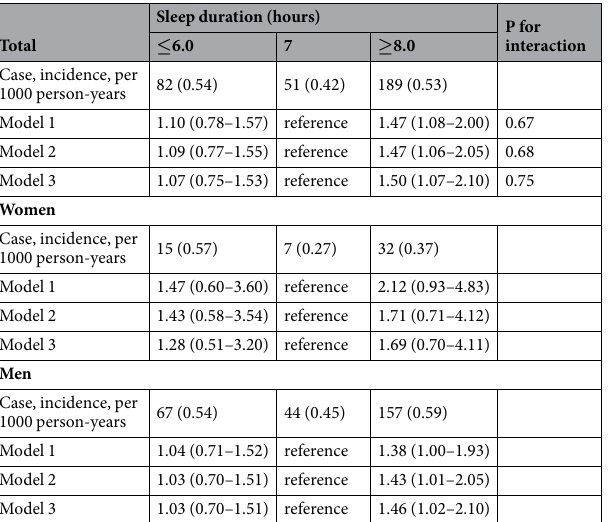
Table 3. Hazard ratios (95% CI) for atrial fibrillation according to sleep duration in the Kailuan Study. Model 1: Adjusted for age and sex. Model 2: Adjusted for age, sex, level of education, smoking, alcohol, physical activity, snoring, and body mass index. Model 3: Adjusted for variables in Model 2 plus hypertension, diabetes mellitus, dyslipidaemia, myocardial infarction, uric acid, and high-sensitivity C-reactive protein.